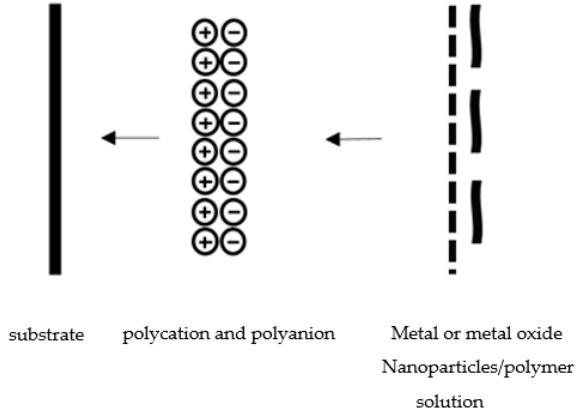
Figure 14. The flow chart of the preparation of ternary composite.